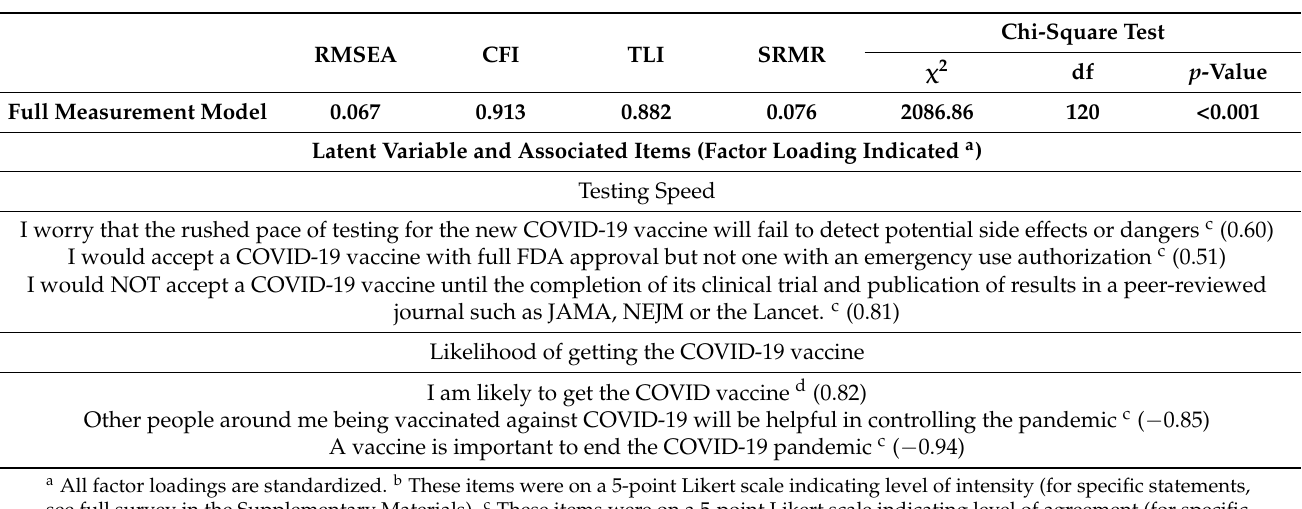
Table 2. Fit statistics for each latent variable and full measurement model.